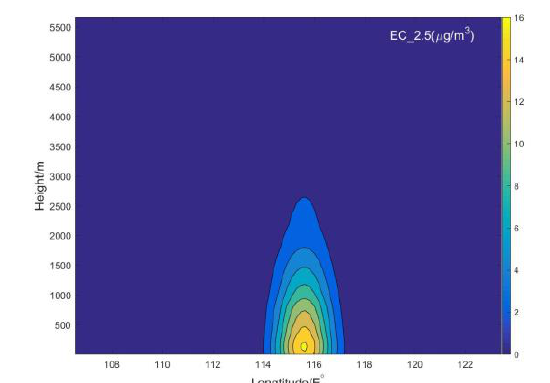
Figure 1 Mass concentrations distribution vertically of the No.1